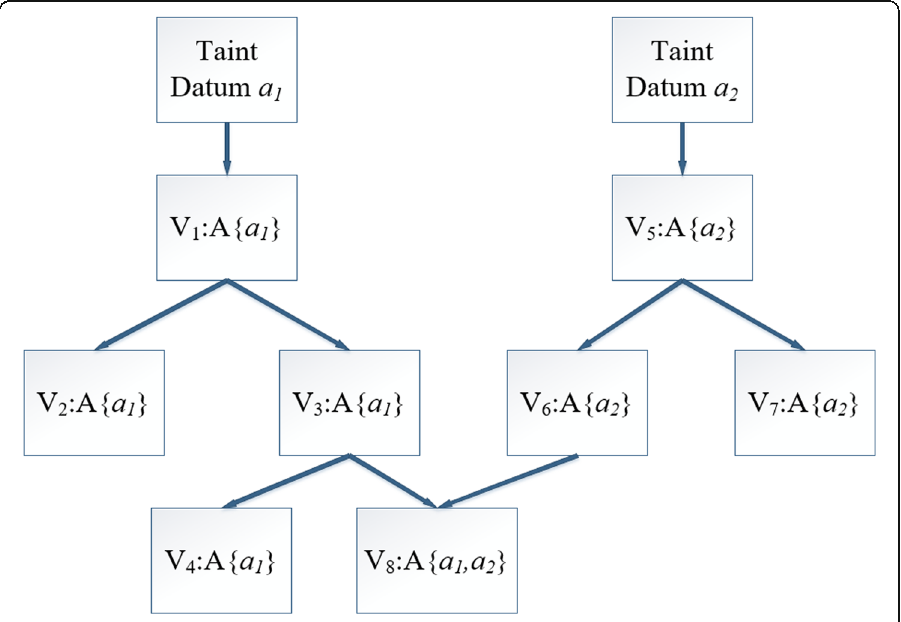
Fig. 2 An example of dynamic taint